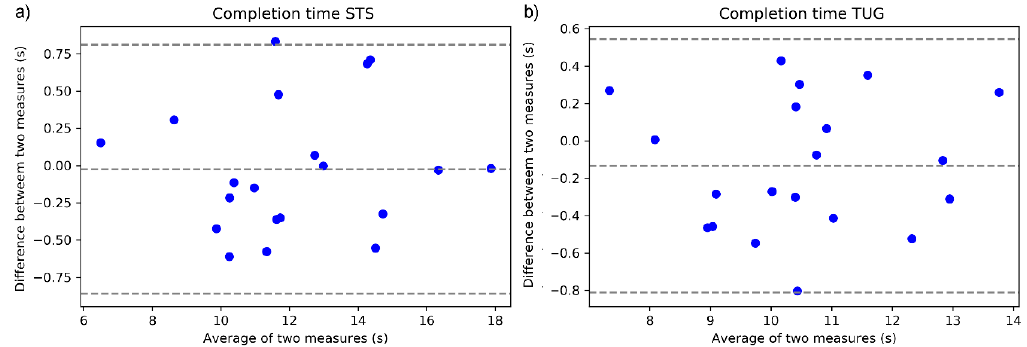
Figure 3. Bland-Altman plot of the sensor-derived and stopwatch timed task completion time. ( a ) STS completion time; and ( b ) TUG completion time. The Y -axis indicates the difference between the measures (a positive value indicates that the stopwatch measure is larger than the sensor-derived measure).